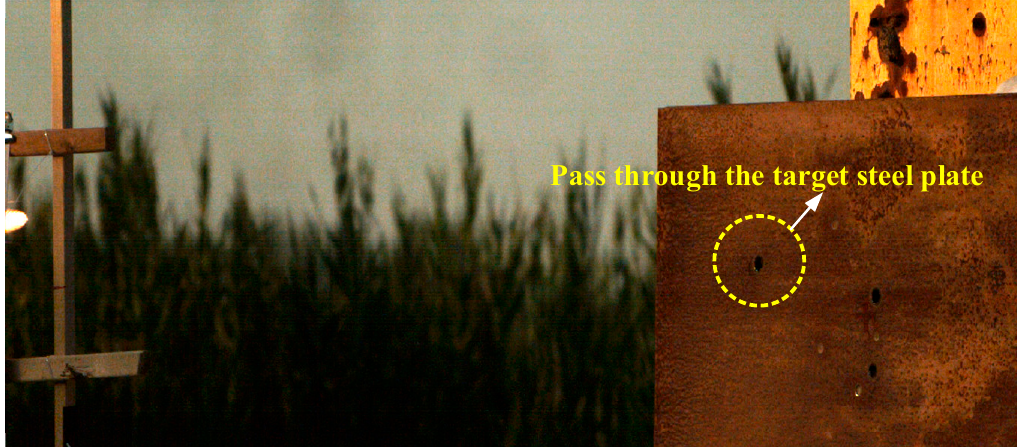
Figure 6. Movement process of the projectile. ( a ) t = 1.2 ms; ( b ) t = 1.4 ms.